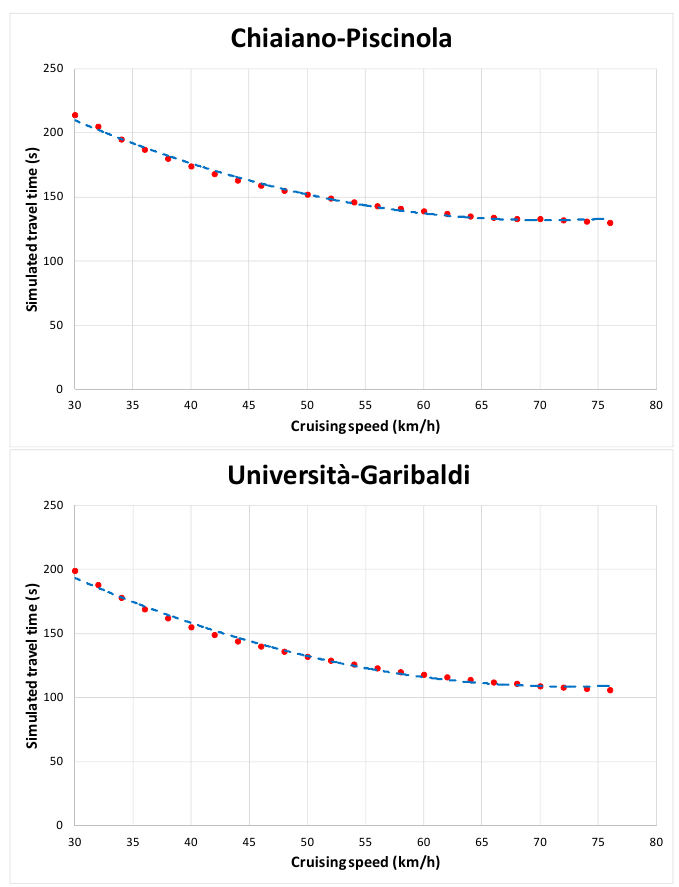
Figure 7. Examples of the relationship between travel time and cruising speed.